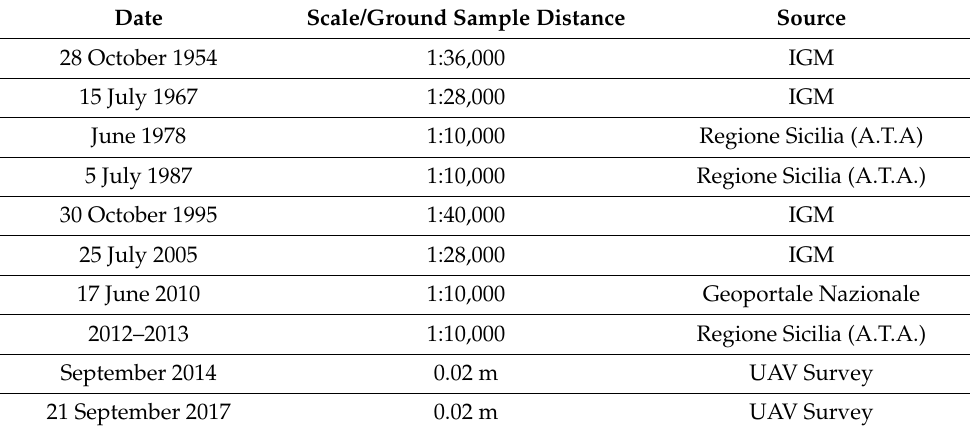
Table 1. Data used for reconstructing the shoreline variations through traditional aerial photographs and UAV-based surveys. IGM: Istituto Geografico Militare, Italy; A.T.A: Assessorato Territorio e Ambiente, Regione Sicilia,